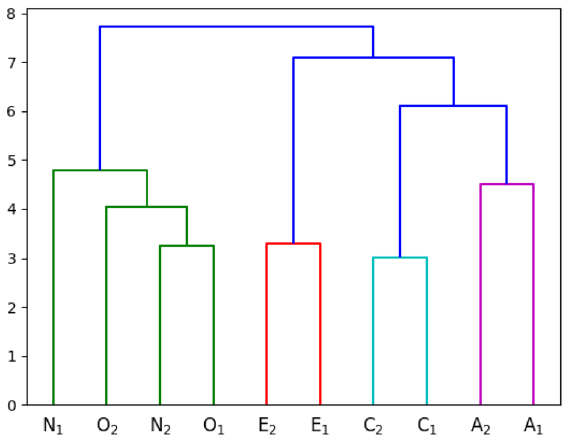
Figure 2. Dendrogram of the learned Joint Importance profiles for Personality traits in different datasets. Number {1, 2} in the subscript denotes the dataset number. Each color represents cluster at some level.